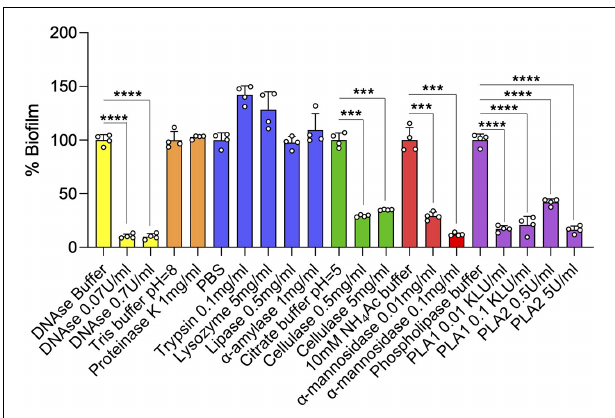
FIGURE 5 | Effect of enzyme treatments on MABSC biofilm dispersal. Mature 4-day-old biofilms were treated with DNase, lipase, phospholipases A1 (PLA1) and A2 (PLA2), cellulase, α -amylase, α -mannosidase, lysozyme, proteinase K, or trypsin for 20 h at 37 ◦ C. The biofilms remaining after treatment were washed and quantified by crystal violet staining. The values are expressed as percentages of the values obtained for the controls (treatment with PBS or other enzyme buffers alone). Biofilm assays run in the same buffer are colored similarly. Quantification was performed on four wells per treatment. Two independent experiments were performed with similar results. Asterisks denote statistically significant differences between enzyme treatment and control groups (enzyme buffer without enzyme) pursuant to the Student’s t -test (*** p < 0.0005, **** p <